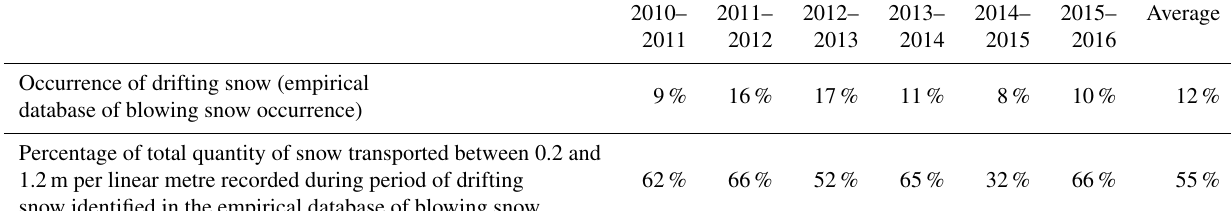
Percentage of total quantity of snow transported between 0.2 and